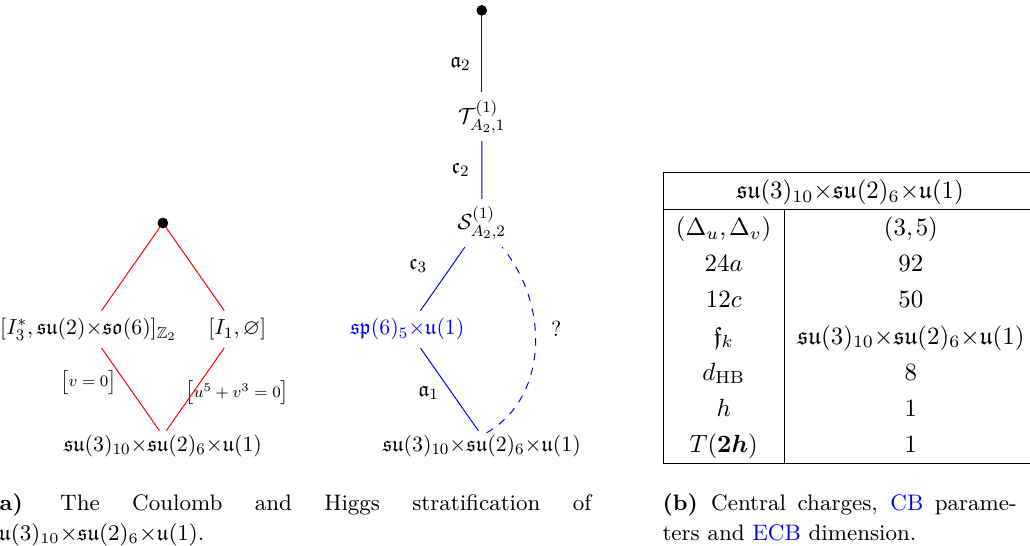
Figure 25. Information about the su (3) 10 × su (2) 6 × u (1)